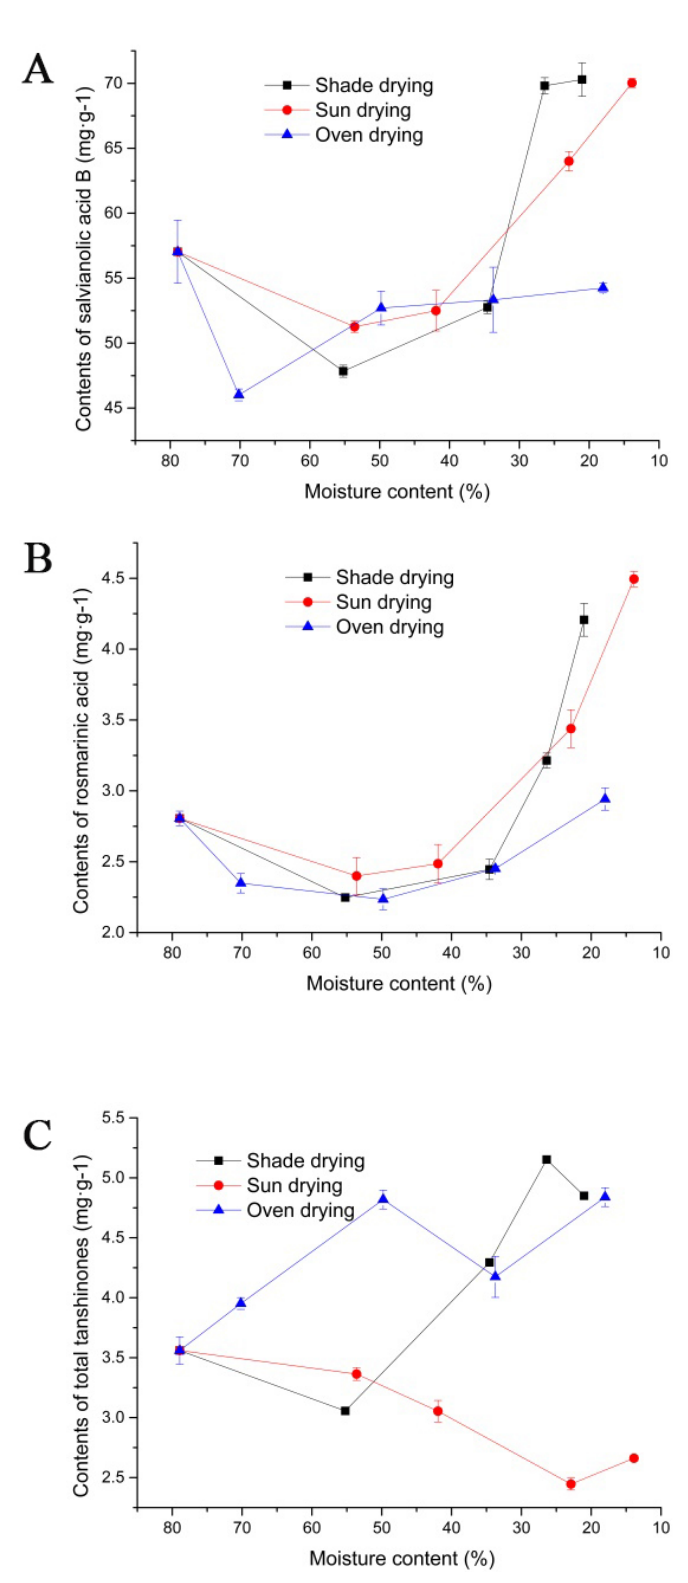
Figure 4. Changes in S. miltiorrhiza ingredient contents in different drying conditions during fresh processing. ( A ) Salvianolic acid B; ( B ) rosmarinic acid; ( C ) total processing. ( A ) Salvianolic acid B; ( B ) rosmarinic acid; ( C ) total tanshinones.